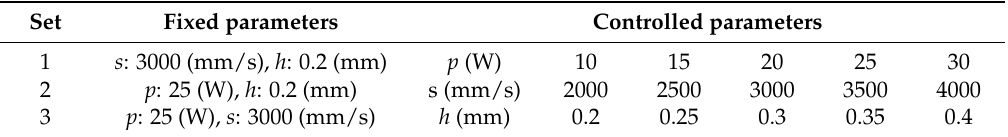
Table 2. The sets of process parameters for CNTs/PA12 laser sintering.